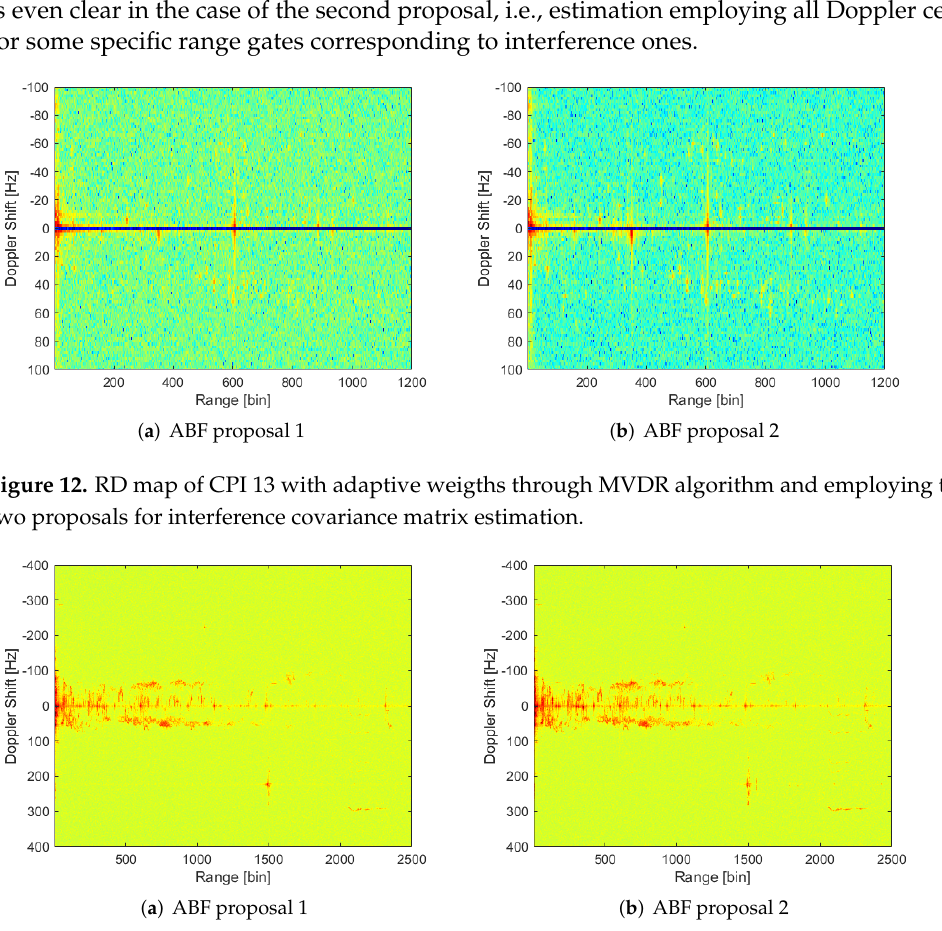
Figure 13. Results of processing the 158 CPI with adaptive weights through MVDR algorithm generating first beam and employing the two proposals for interference covariance matrix estimation.